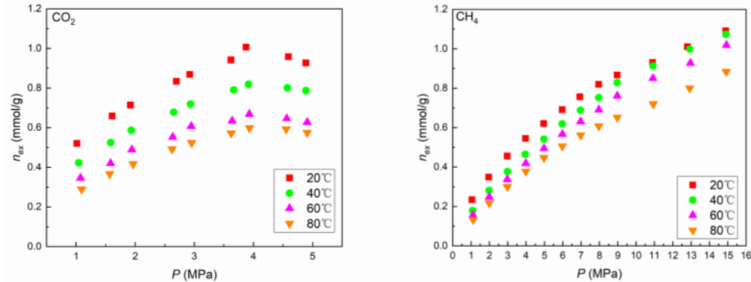
Figure 4. The excess adsorbed amounts of CO 2 and CH 4 on the shale